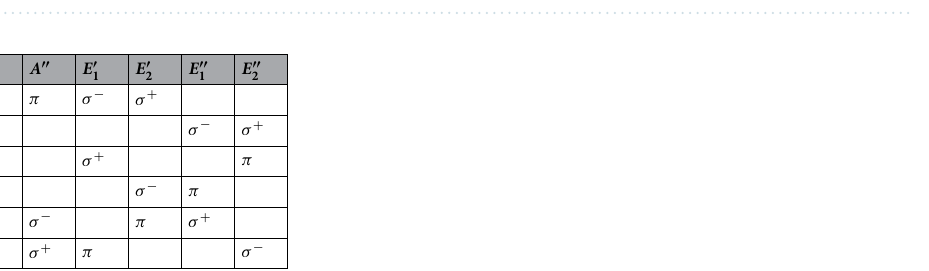
1 3 for σ ± transitions = ± ± 3 is due to the C 3 rotational symmetry of the lattice. These ± and E g , || ⊥ 2 2 2 0.75 , (cid:31) 0.25 , (cid:31) 0.75 , α VB 2, β VB 1, α CB 2,0 (cid:31) 2 (cid:31) 1 (cid:31) = = = (cid:31) (cid:31) (cid:31) (cid:31) (cid:31) (cid:31) ± ±